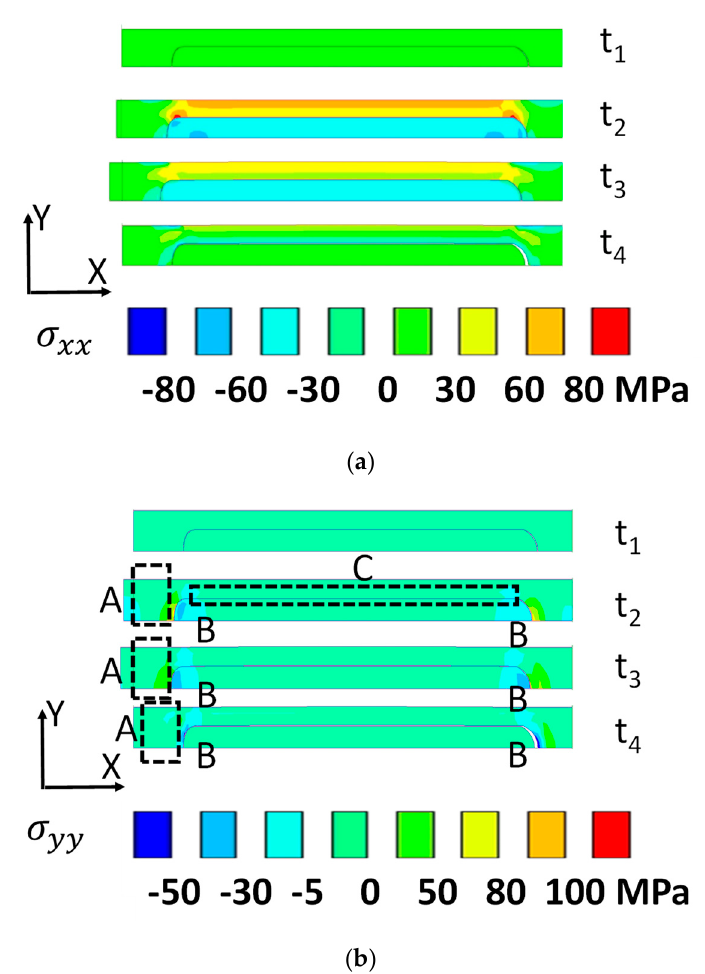
Figure 15. 2D generalized plane strain model with 1 mm of additional material and with an initial gap of 5 µm. ( a ) Axial stress σ xx , ( b ) stress σ yy.